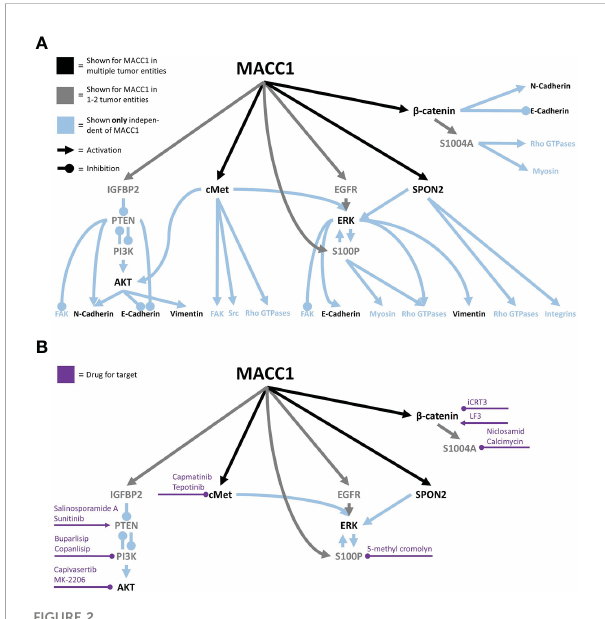
FIGURE 2 The MACC1 signaling network associated with cell migration (A) and potential intervention points, with the associated drugs (B)